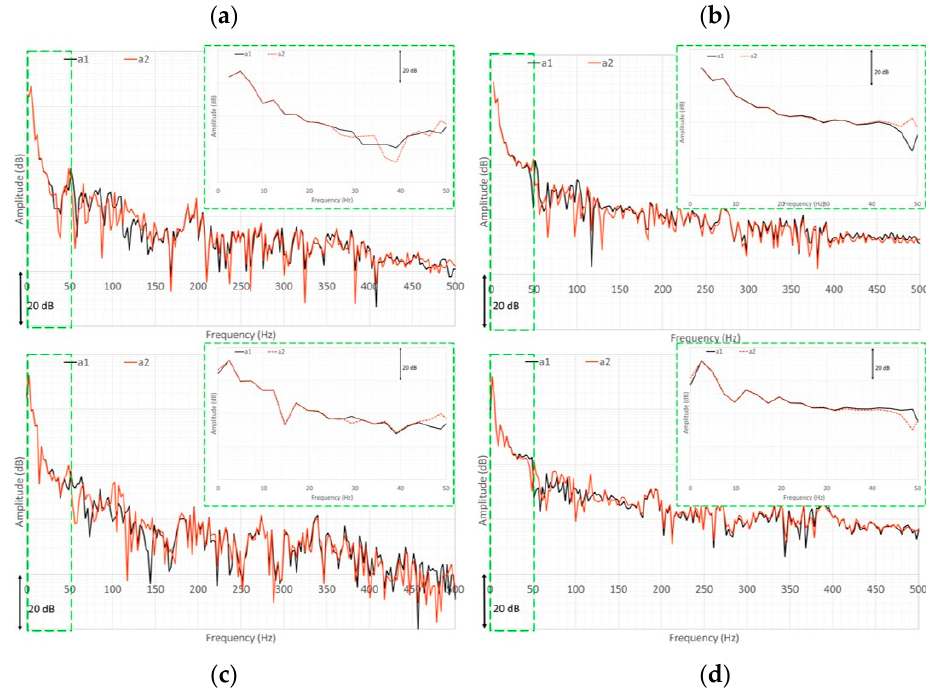
Figure 22. FFT of accelerometers signals in the 4096-ms time windows indicated in Figure 17. The graphs indicated four different heights. ( a ) h = 0.05 m; ( b ) h = 0.10 m; ( c ) h = 0.15 m and ( d ) h = 0.20 m.